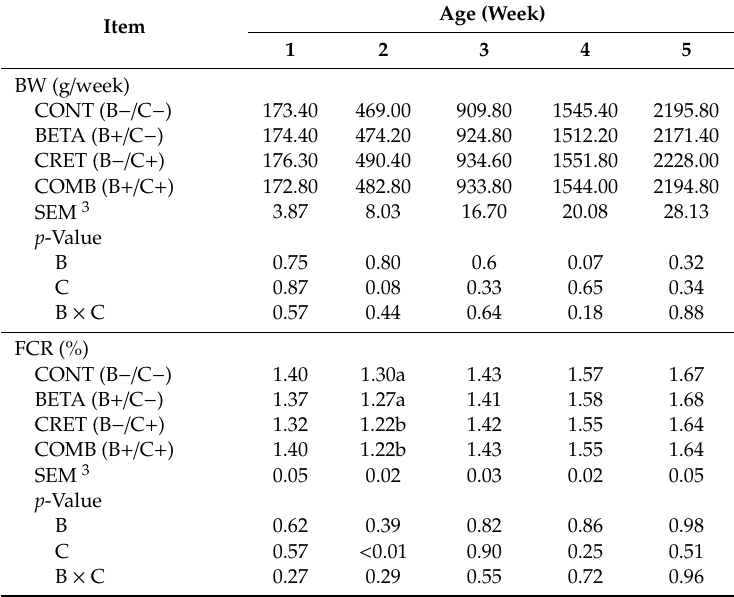
Table 2. Means of body weight (BW), feed conversion ratio (FCR), feed intake (FI), and body weight gain (BWG) of broiler chicks 1 treated with dietary betaine (B) and / or creatine (C) 2